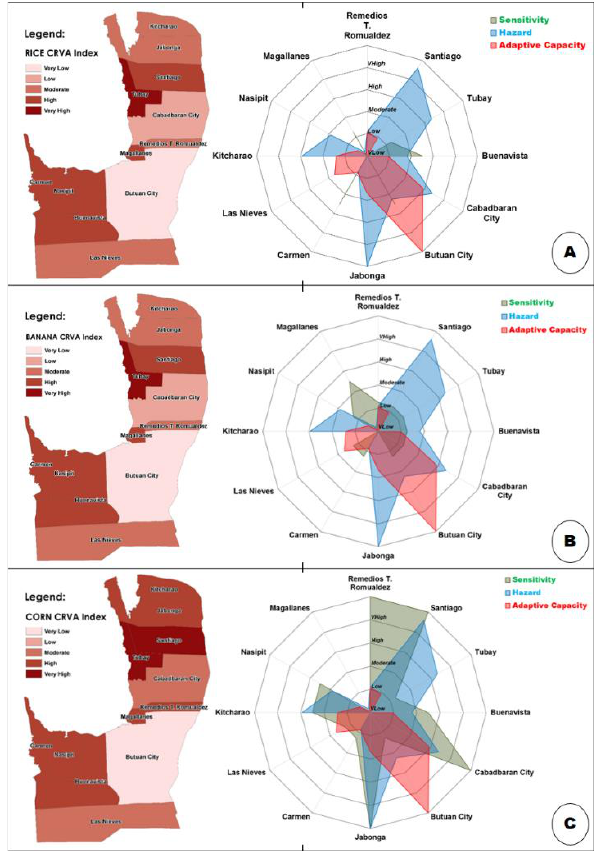
Figure 6. Total CRVA index map for rice (a), banana (b), and corn (c) in Agusan del